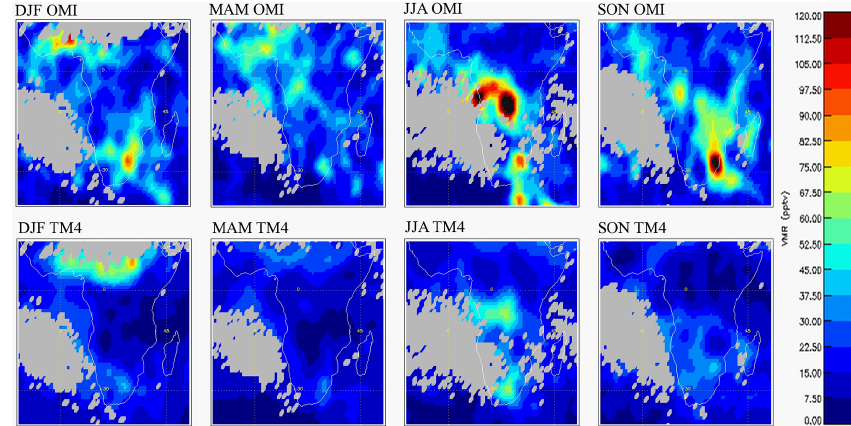
Figure 17. Same as Fig. 15 but at 500hPa.